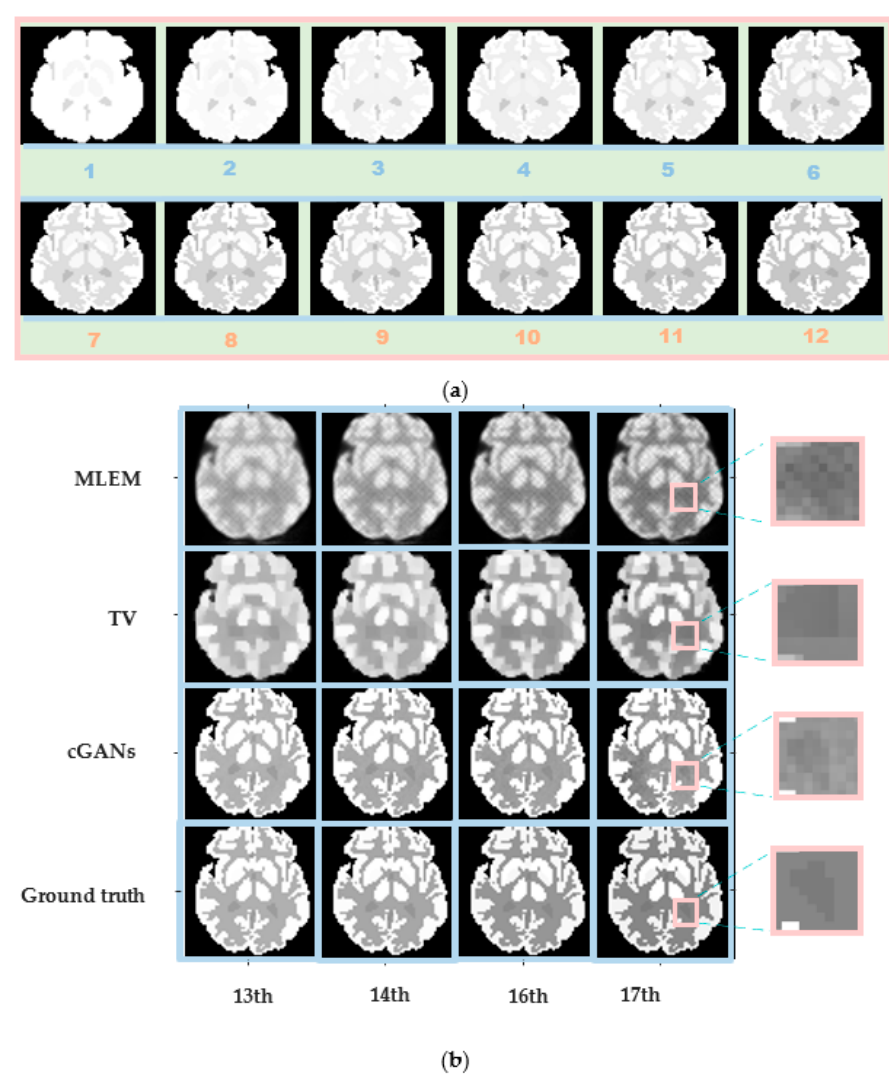
Figure 11. Robustness verification graphs of Zubal head phantom for different frames. ( a ) Concen- tration distribution of training images (the first 12 frames). ( b ) Reconstruction results for Zubal head phantom with a 70 min scan and 5 × 10 7 counts. From top to bottom: MLEM results, TV results, cGAN results, and ground truth. From left to right: the 13th, 14th, 16th, and 17th frames.